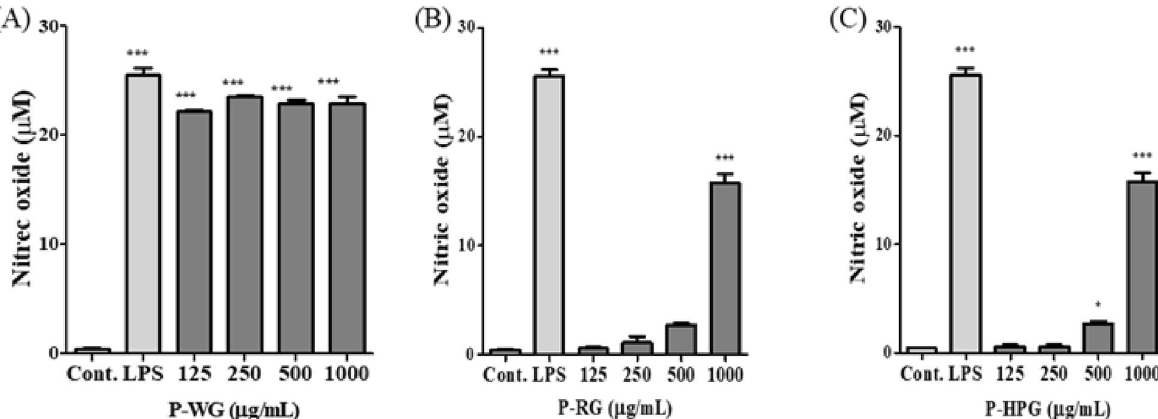
Fig. 6 Effects of P‑WG, P‑RG, and P‑HPG treatments on inducible nitric oxide synthase levels in RAW 264.7 macrophages. RAW 264.7 macrophages were stimulated with P‑WG, P‑RG, or P‑HPG (125, 250, 500, or 1000 mg/mL) for 18 h, after which iNOS levels were evaluated. a iNOS levels determined via immunoblotting. b Quantification of iNOS/GAPDH intensity using the ImageJ software. All data are presented as mean n 3, * P < 0.05 and *** P < 0.0001 compared to control =